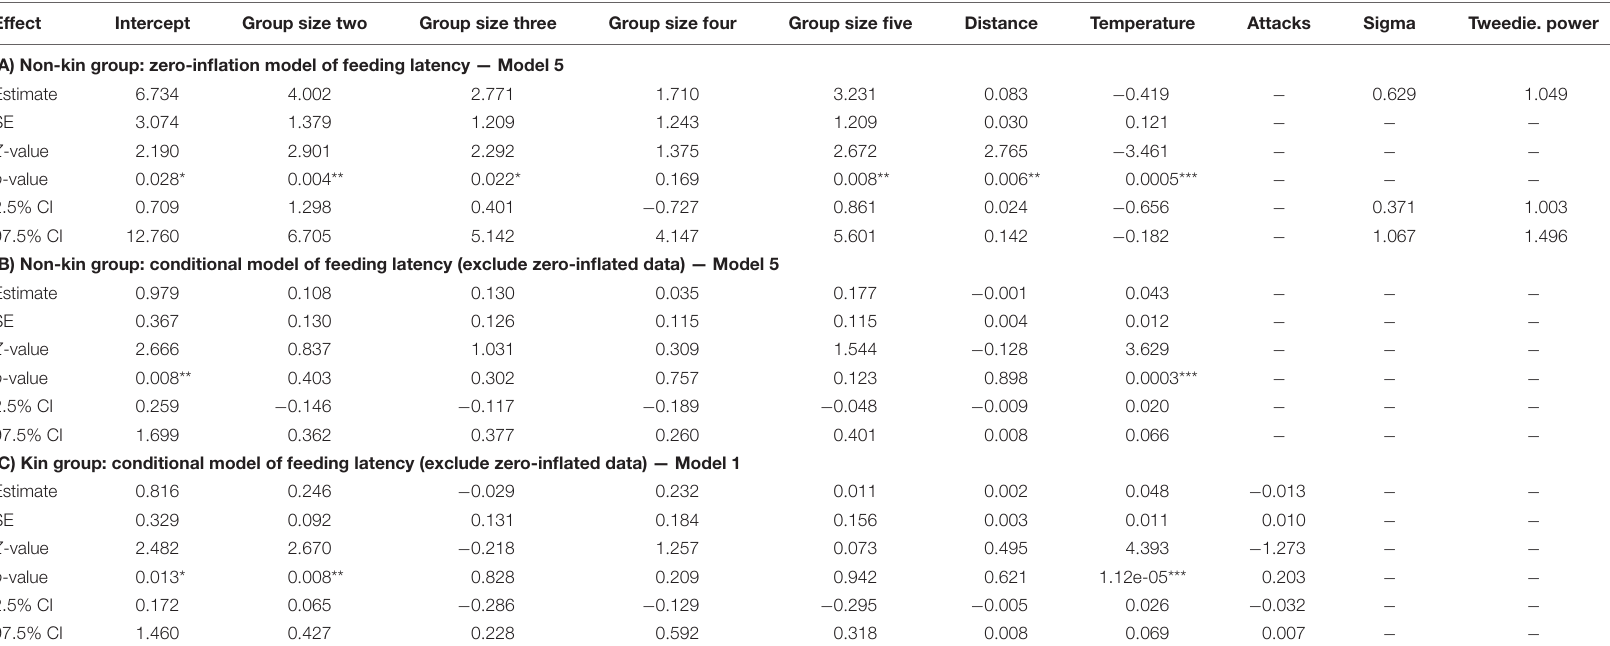
TABLE 2 | Statistical results of feeding latency in response to group size, kinship, distance to the hub, ambient temperature, and host attacks for kin and non-kin groups.